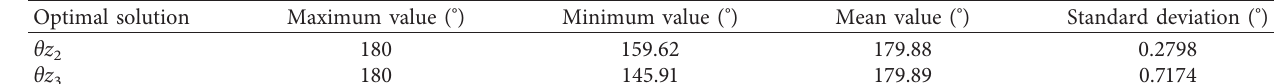
Table 6: The Monte Carlo simulation results.